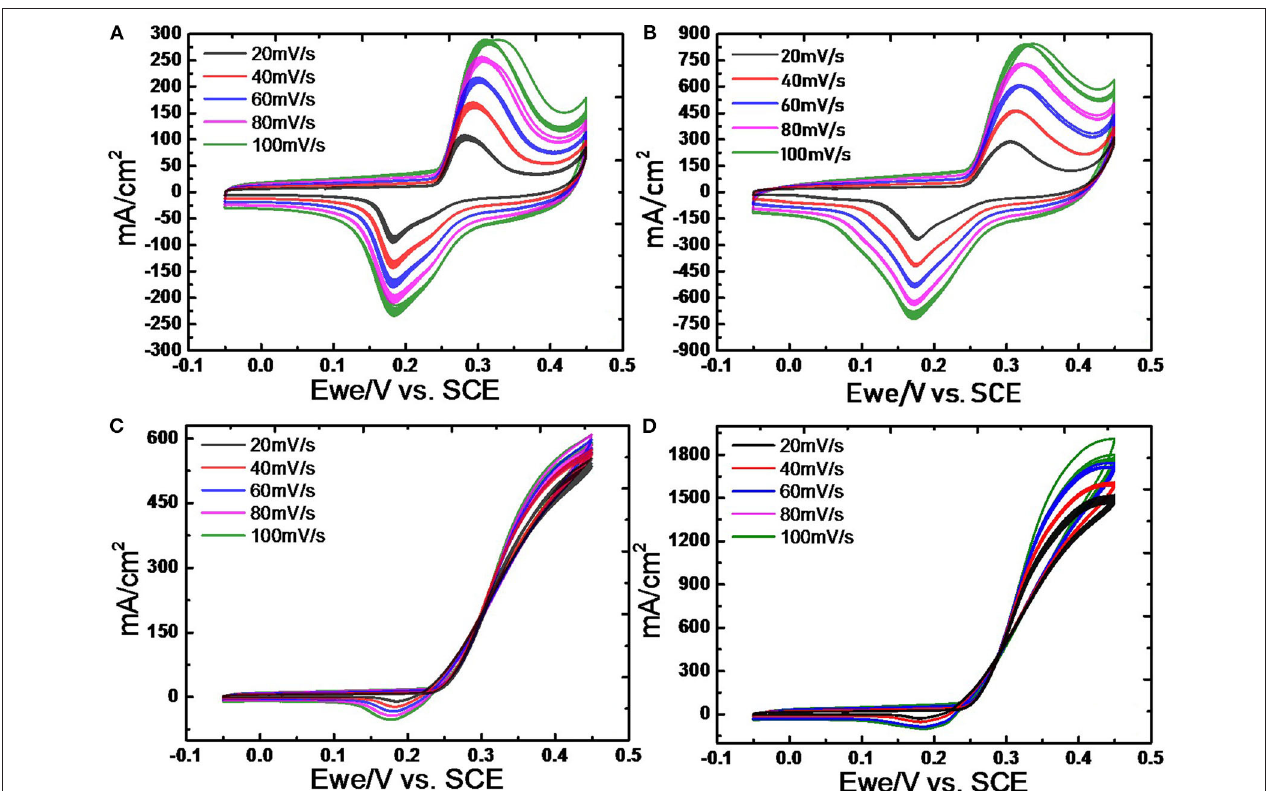
FIGURE 8 | CV profiles of (A) Ni-Pd/MWCNT and (B) Ni-Pd(P)/MWCNT at scan rates of 20, 40, 60, 80, and 100 mV/s in 3.0M KOH solution and 3.0M KOH/1.0M urea solution (C) Ni-Pd/MWCNT and (D) Ni-Pd(P)/MWCNT 20–100 mV/s scan